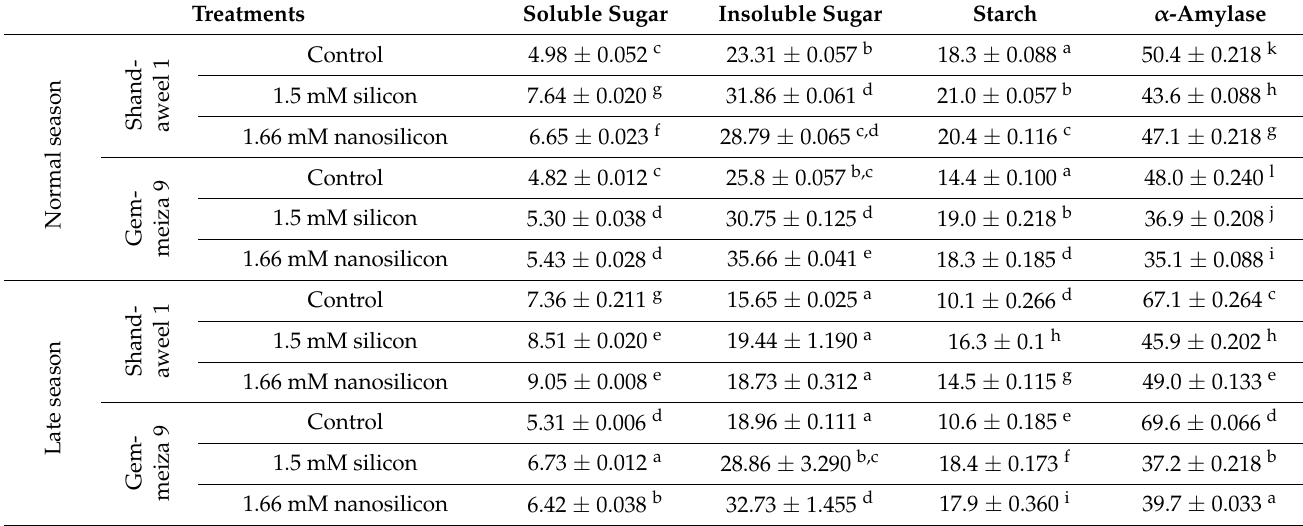
Table 3. Effects of silicon and nanosilicon on soluble, insoluble sugar, starch and α -amylase activity (mg sugar/min./g DW) of two wheat cultivars grains cv. Shandaweel 1 and cv. Gemmeiza 9 at normal and late seasons. Each value is the main of three different replicates ±